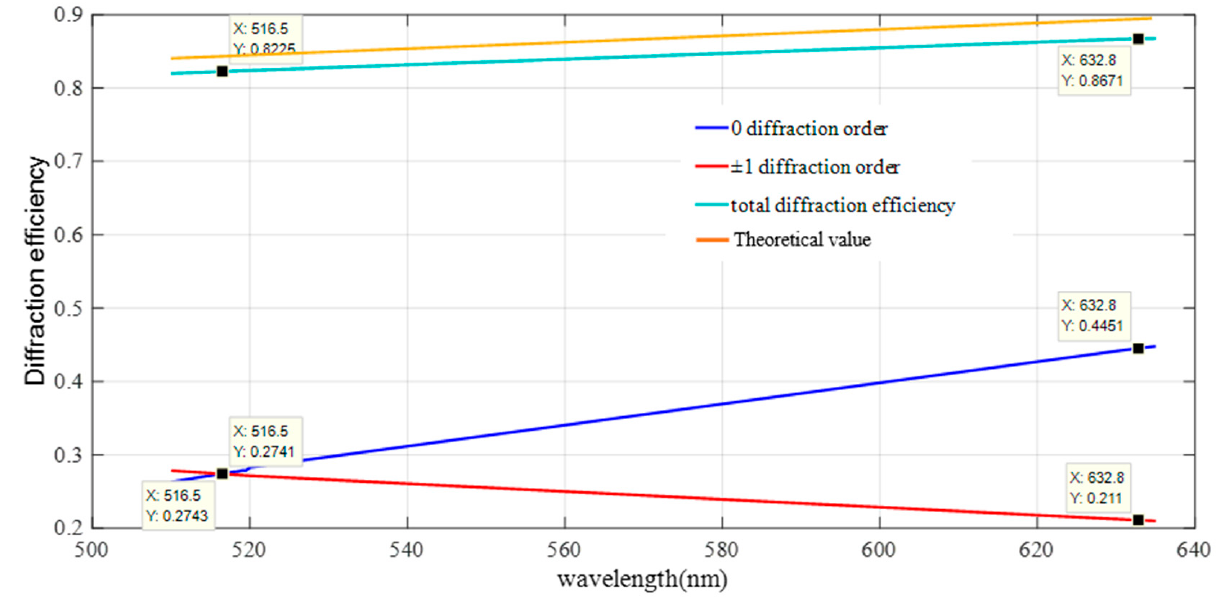
Figure 10. Inversion results of aberrated off-axis Fresnel wave with slice slot type test. The diffraction efficiency test optical system of the single wavelength (516.5